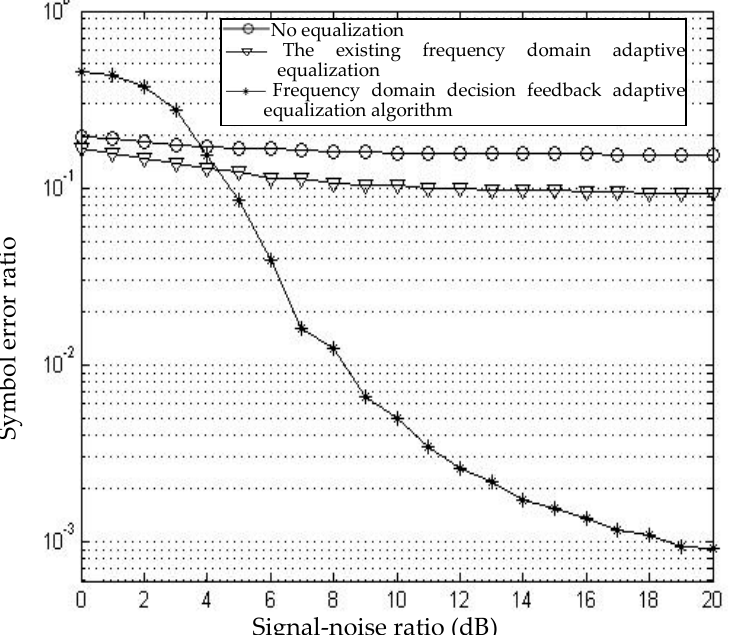
Figure 6. Symbol error ratio curve for Channel 2 with two frequency domain equalization algo- rithms.